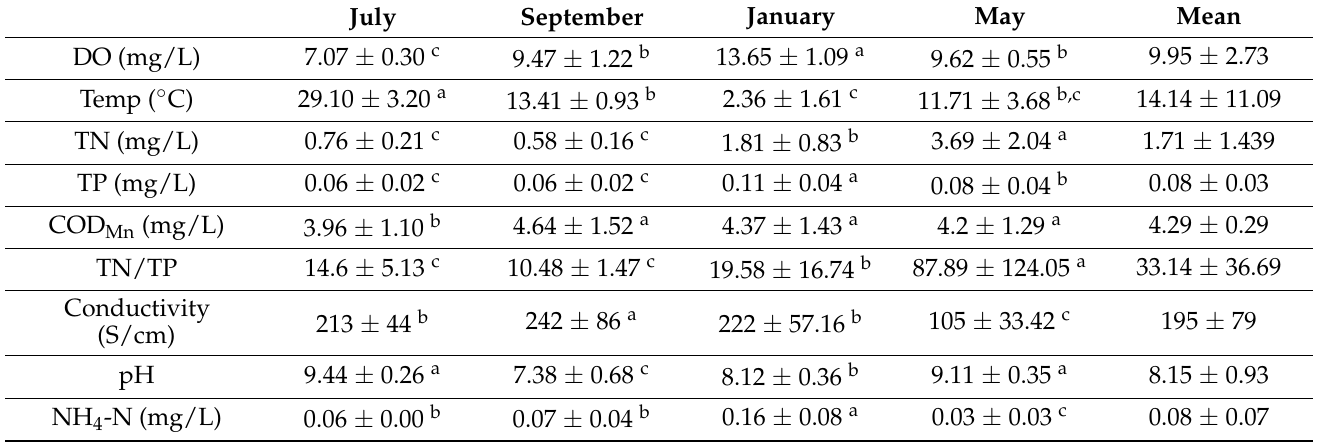
Table 2. Environmental variables summarized as means ± standard errors in the XKL basin in January, May, July, and September. One-Way ANOVA was used to explore the differences in physicochemical parameters between different months. July and September represent bloom period, while January and May represent non-bloom